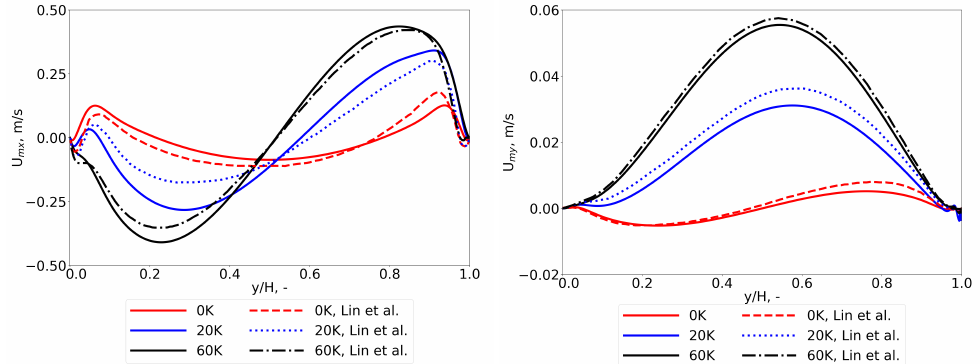
Figure 3. Comparison of the current results with [4] for various temperature difference between the top and bottom wall; ( Left ): plots of u mx along height of the domain for x = 0.75 L; ( Right ): plots of u my for x = 0.5 L.